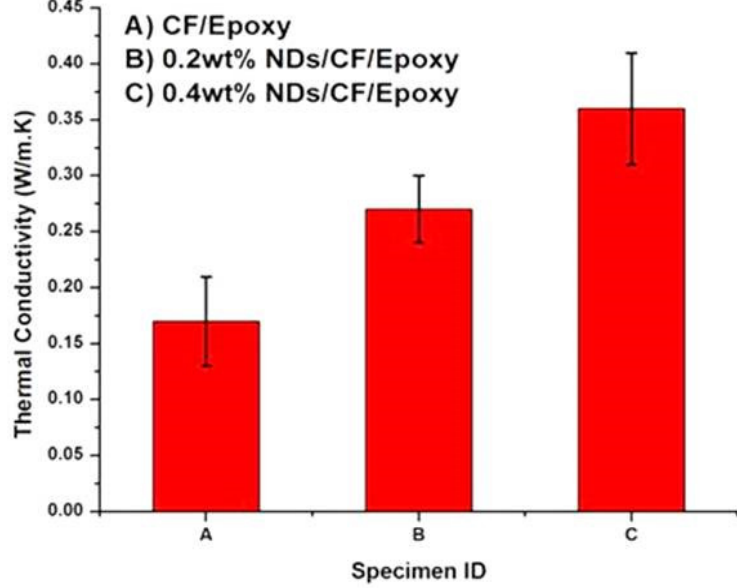
Figure 6. Thermal conductivity values of ( A ) CFRE-C, ( B ) CFRE-C containing 0.2 wt% NDs, and